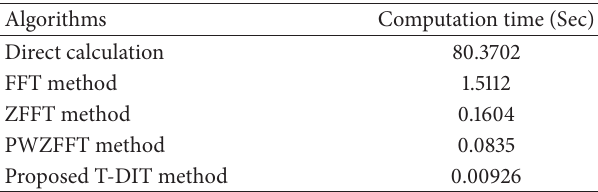
Table 4: Comparison of the required computation